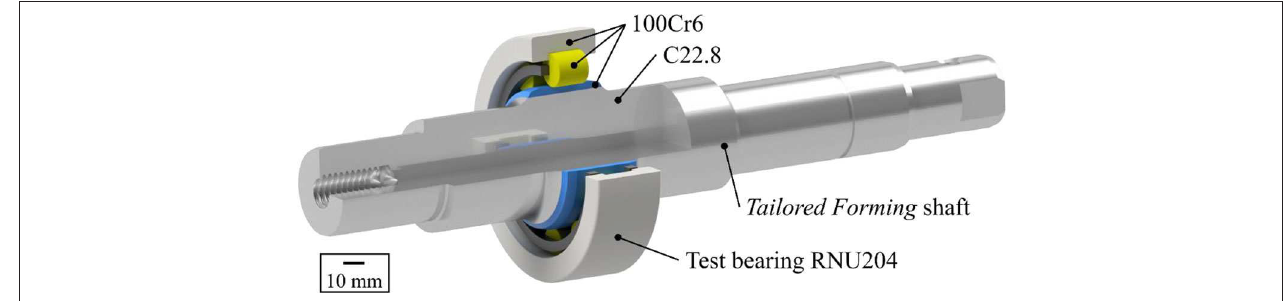
FIGURE 1 | Tailored Forming